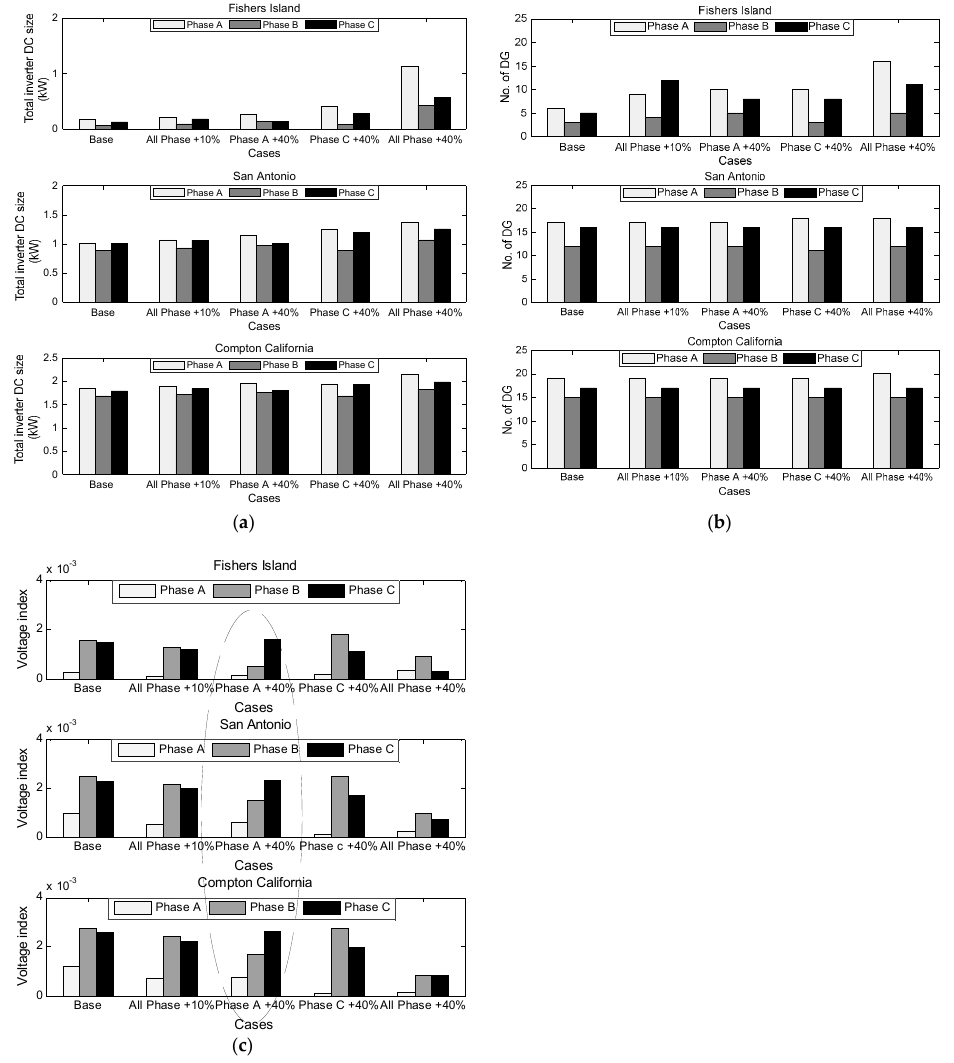
Figure 14. Optimal solution for the inverter size and its corresponding voltage index. ( a ) Inverter size. ( b ) Total number of PVs installed at nodes. ( c ) Voltage index.